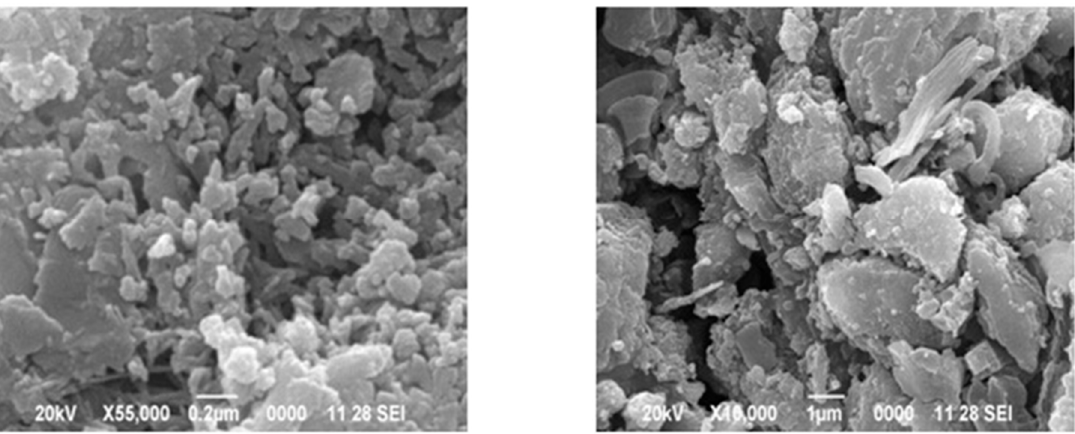
Figure 11. SEM micro graph of EOF steel slag, ( a ) magnification ×55,000, and ( b ) magnification ×100,000.